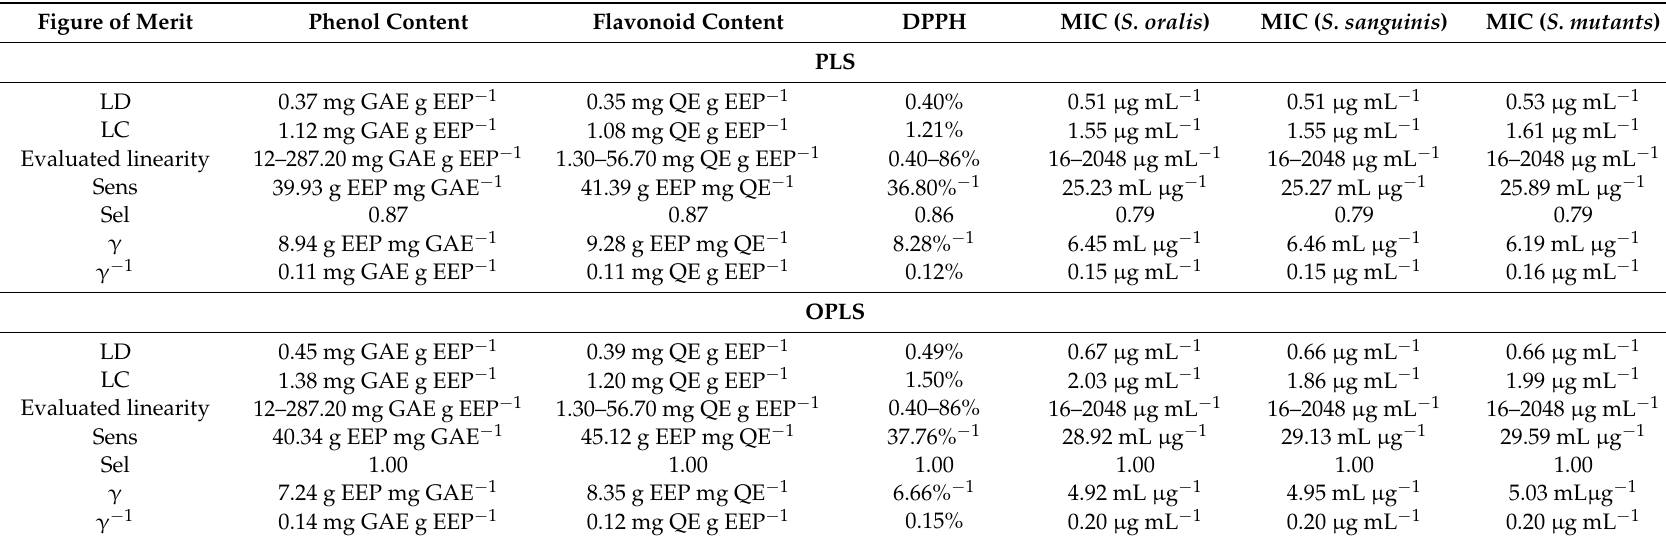
Table 3. Figures of merit of the PLS and OPLS